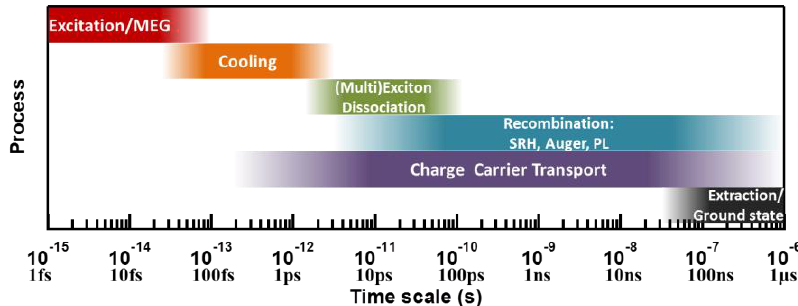
Figure 1. Schematic outline showing the different timescales of the processes in the lifetime of a